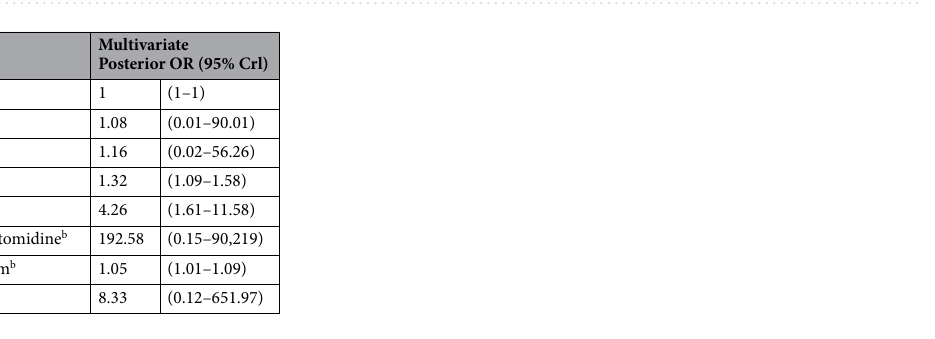
Figure 3. Associations between NSE and conscious status. The figure shows the association between NSE and conscious status in lower concentrations of NSE: normal status is (red line) the highest probability while, at the middle range of NSE, the provability of delirium status (green line) gradually increases. In the situation of higher NSE concentrations, coma status (blue line) has the highest probability. This result indicates that coma, delirium and normal statuses are hierarchically associated with NSE.